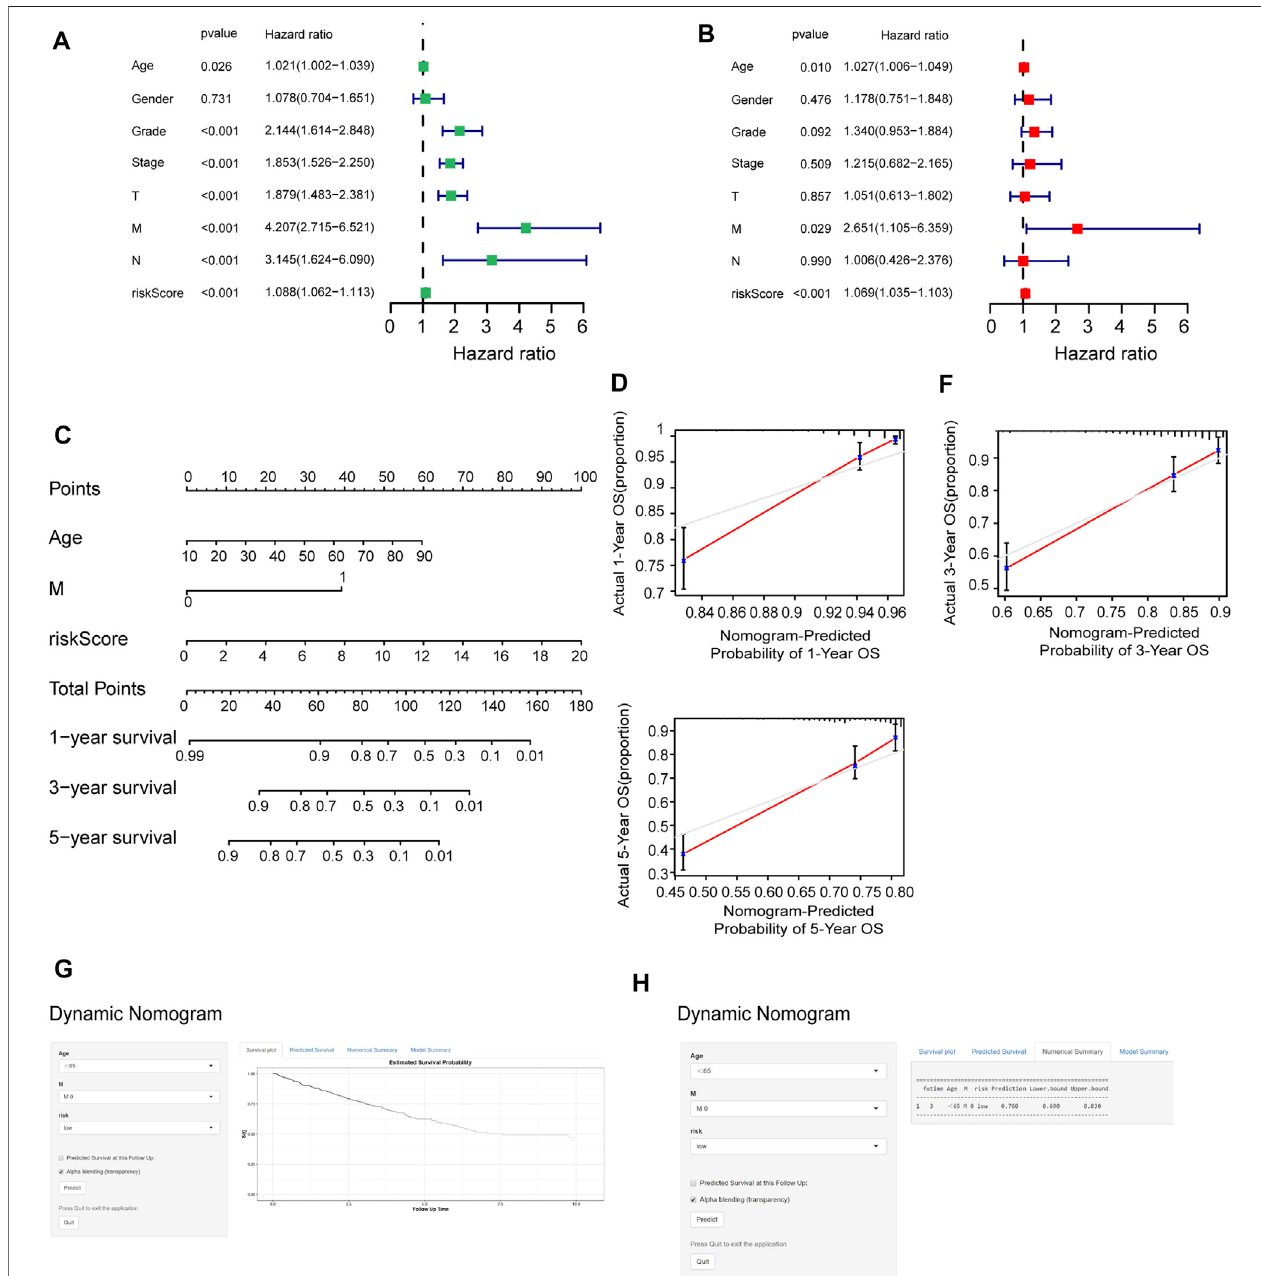
FIGURE8| Assessmentoftheaccuracyoftheprognosticmodel. (A,B) Univariate (A) andmultivariate (B) Coxregressionanalysesfortherelationshipbetweenrisk score and clinical features. (C) Construction of the nomogram model. (D – F) The calibration curves of 1, 3, and 5 years in the nomogram. (G) Patients with low-risk, M0 stage, and aged < 65 years, according to the web survival rate calculator (95% CI 69 – 83%). (H) 95% con fi dence interval according to the web survival rate calculator.